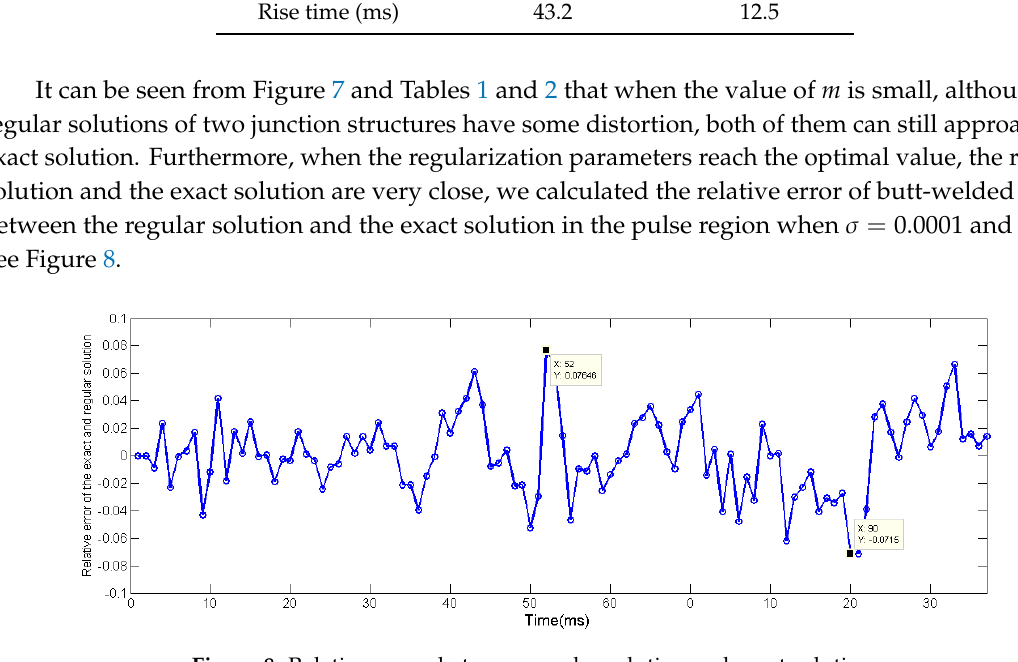
Figure 8. Relative errors between regular solution and exact solution.